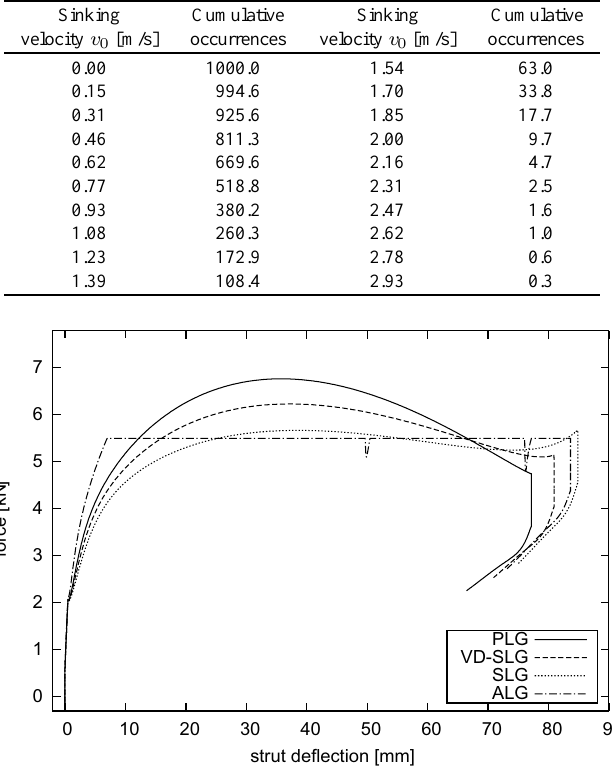
Table 2 Assumed cumulative occurrences of sinking velocities per 1000 landings